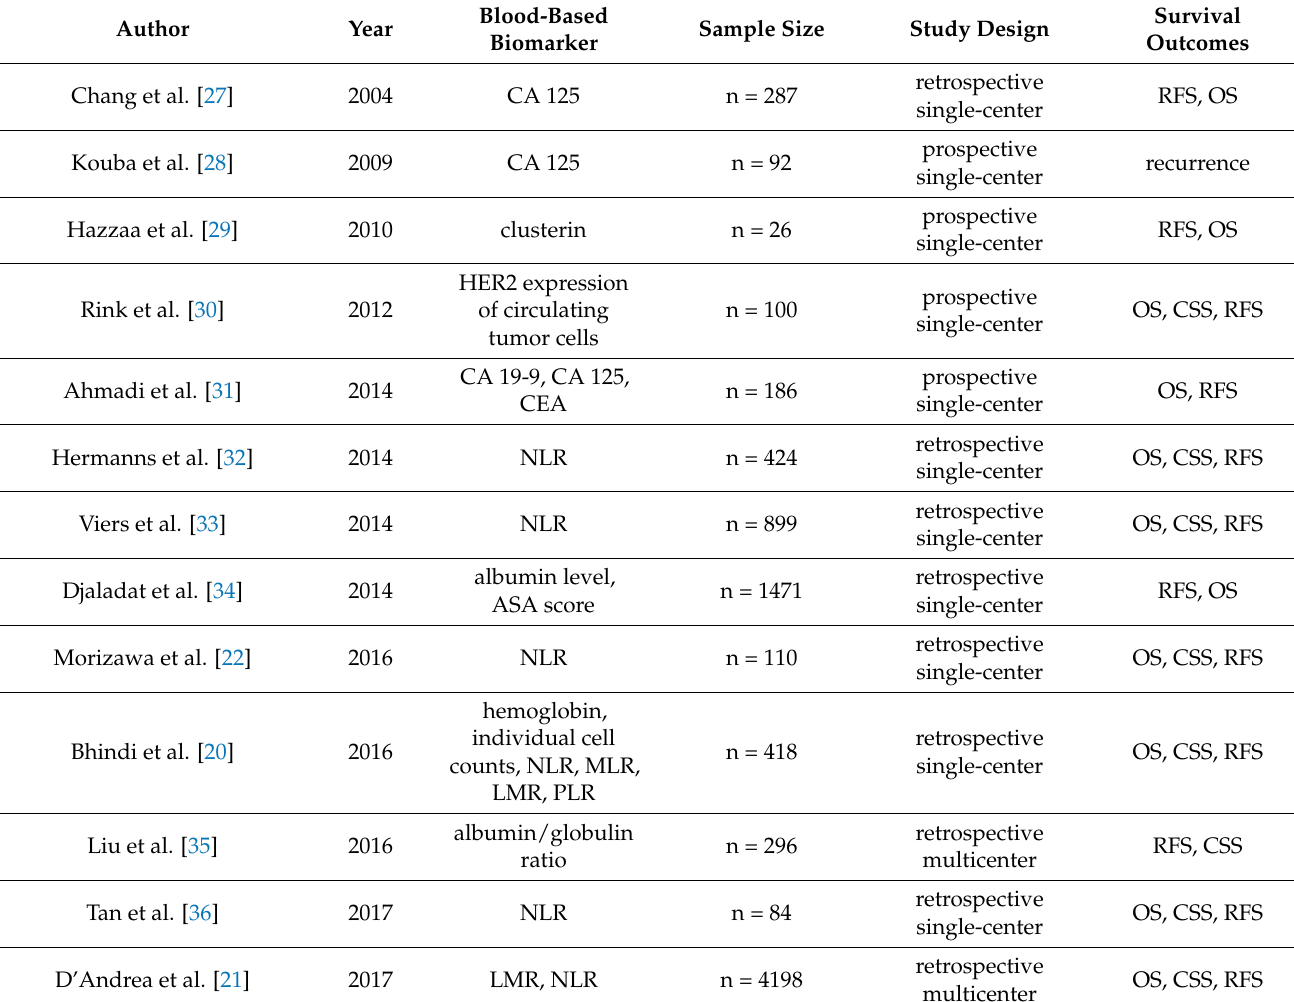
Table 1. Eligible studies for the systematic review and their study